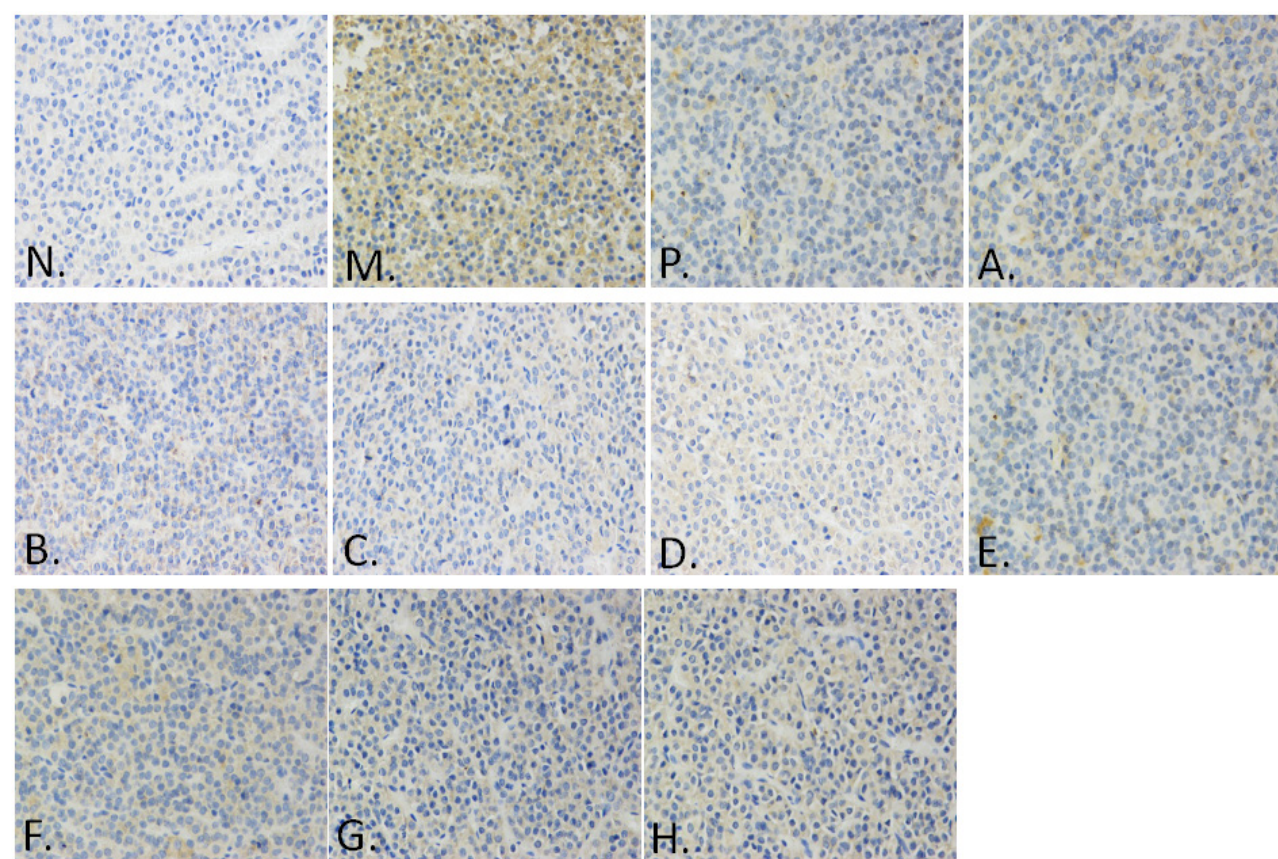
FIGURE 4 – PRL cell positive expression in the pituitary was observed by microscope (original magnification, 400 ×). The positive expression of PRL cell in the pituitary was brown in cytoplasm, and the darker the color was, the greater its positive expression was. (N) normal group; (M) model group; (P) bromocriptine group; (A) 0.25 cm bud of malt group; (B) 0.50 cm bud of malt group; (C) 0.75 cm bud of malt group; (D) 1.00 cm bud of malt group; (E) 1.25 cm bud of malt group; (F) 1.50 cm bud of malt group; (G) 1.75 cm bud of malt group; (H) 2.00 cm bud of malt